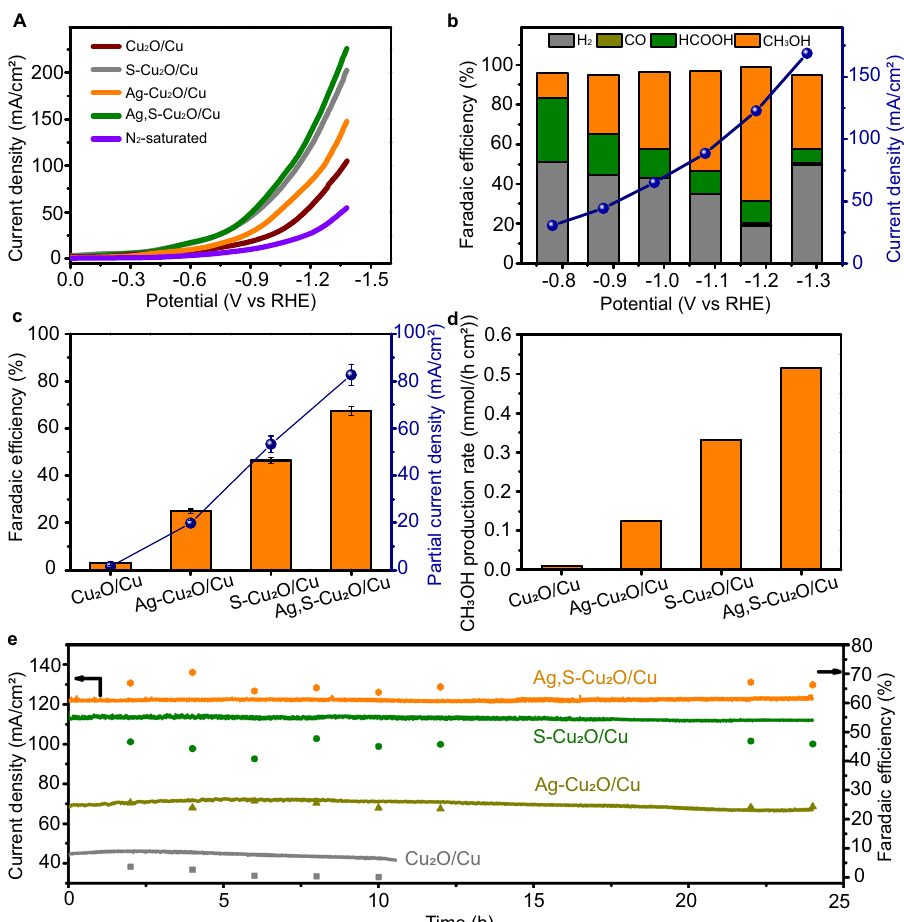
Fig. 2 High CO 2 -to-methanol performance of Ag,S-Cu 2 O/Cu electrocatalyst. a Linear sweep voltammetry (LSV) curves of various catalysts in CO 2 - saturated or N 2 -saturated BMImBF 4 /H 2 O (mole ratio is 1:3) electrolyte with the scan rate of 10 mV s − 1 . b Potential-dependent product selectivity and total current density for CO 2 RR by Ag,S-Cu 2 O/Cu electrode. c The FE of methanol and corresponding partial current density of CO 2 RR catalyzed by different catalysts. Error bars represent the standard deviations from multiple measurements. d Methanol production rates over different catalysts. e Long-term stability over different catalysts. Electrolysis experiments were carried out at − 1.18 V vs.